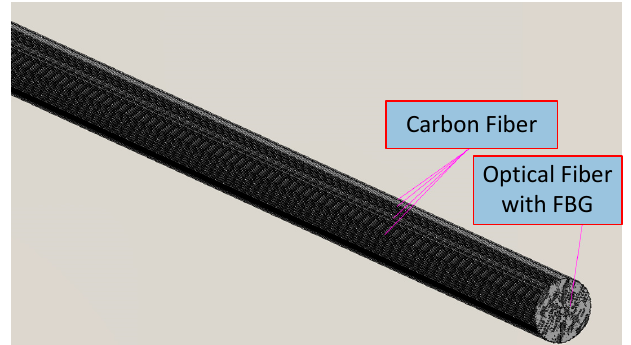
Figure 1. The structure of a carbon fiber smart bar.